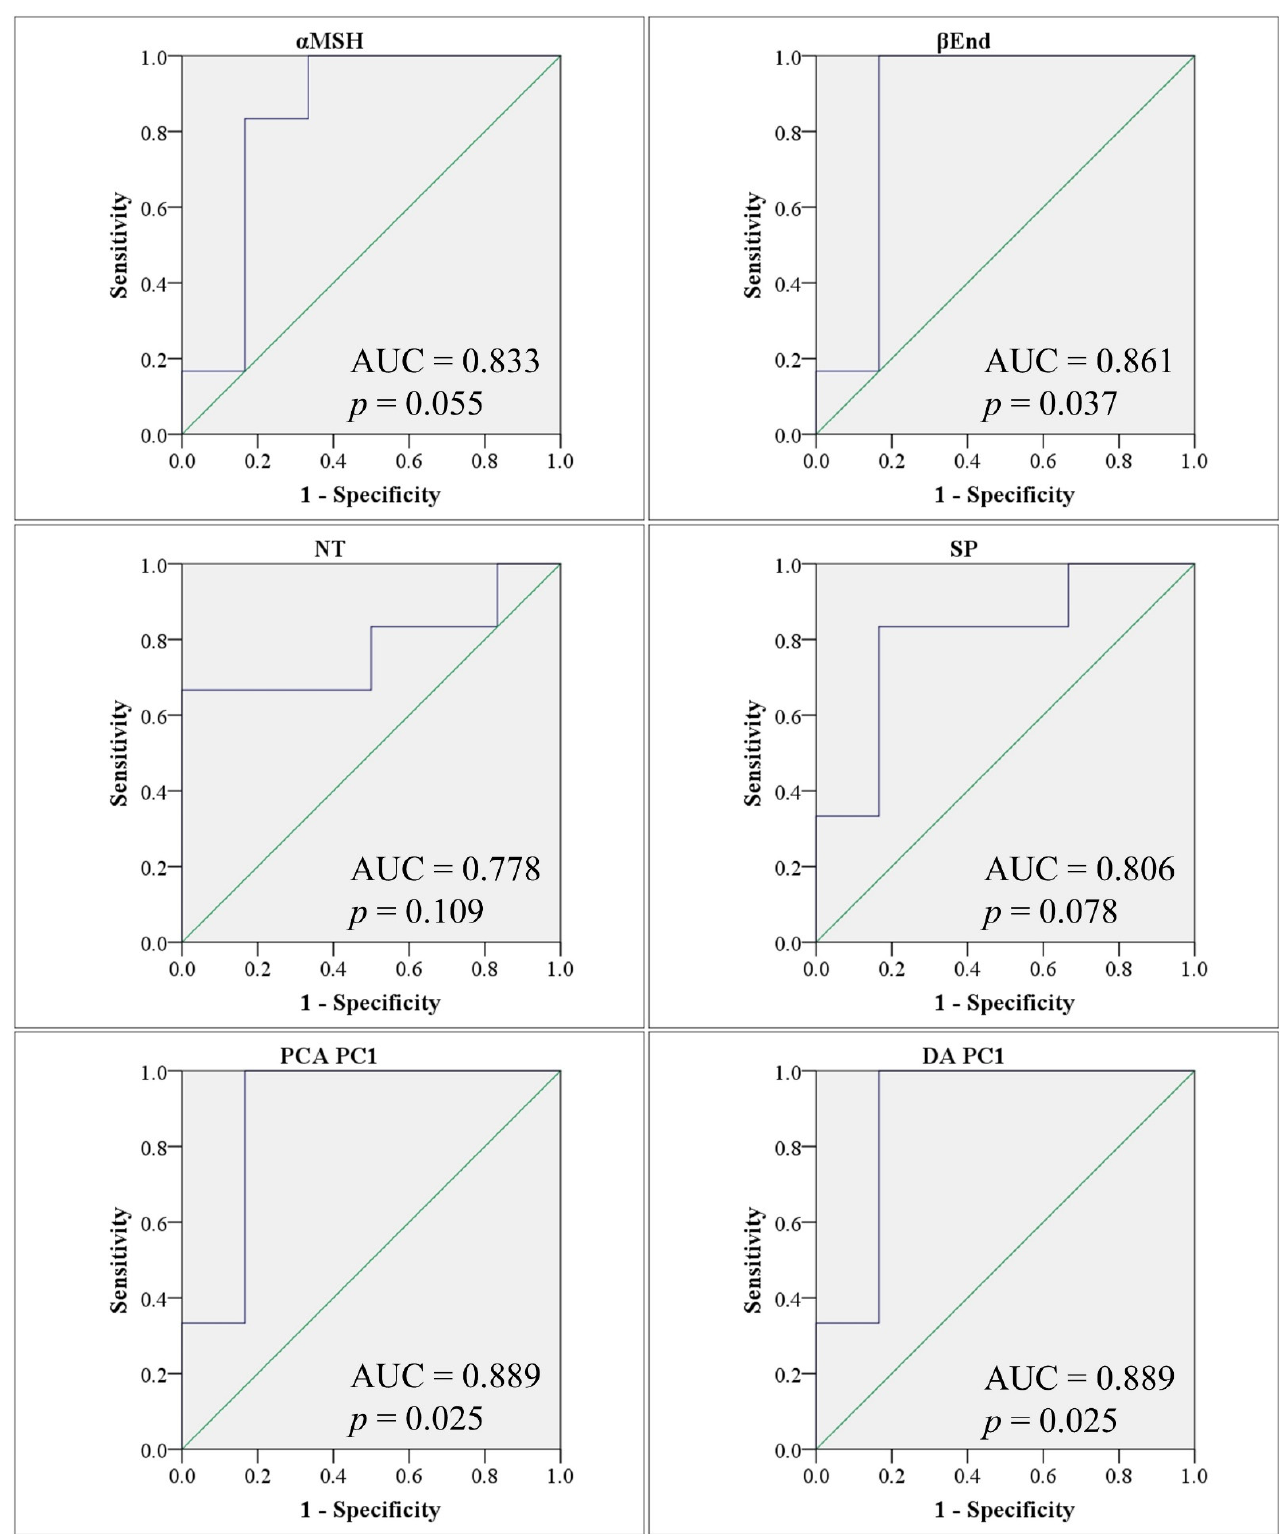
Figure 3. Receiver operating characteristic (ROC) curves showing area under the curve (AUC) obtained using individual biomarkers (top two rows), principal component analysis PC1 scores (PCA PC1) (bottom left), and discriminant analysis PC1 scores (DA PC1) (bottom right) to differentiate between PPA and control animals. AUC values and significance p values are shown for each ROC curve. ROC curves are shown in blue and the diagonals (marking an AUC of 0.5) are shown in green.